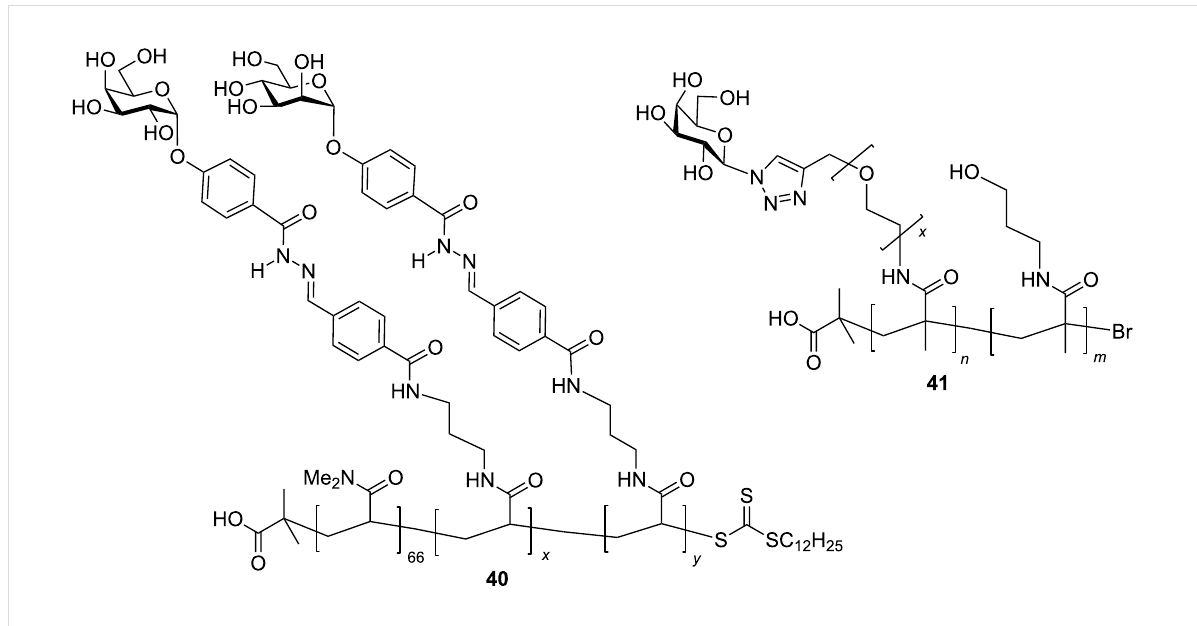
Figure 18: Glycopolymers with exchangeable sugar ligands and variable length linkers.